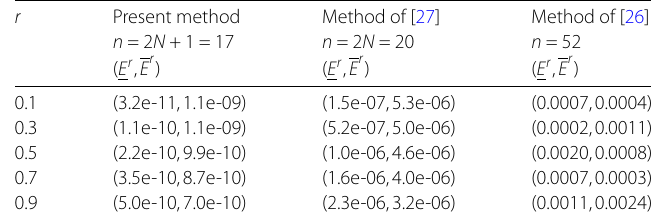
Table 2 Comparison of methods with ( x , y ) = (0.3.0.6) of Example